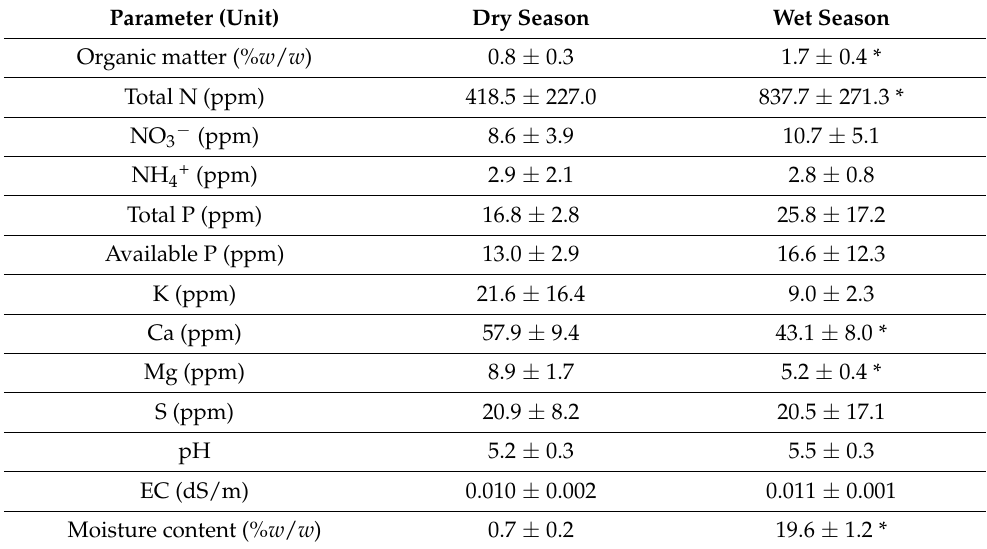
Table 1. Chemical properties of soil collected from the study site in the dry and wet seasons.